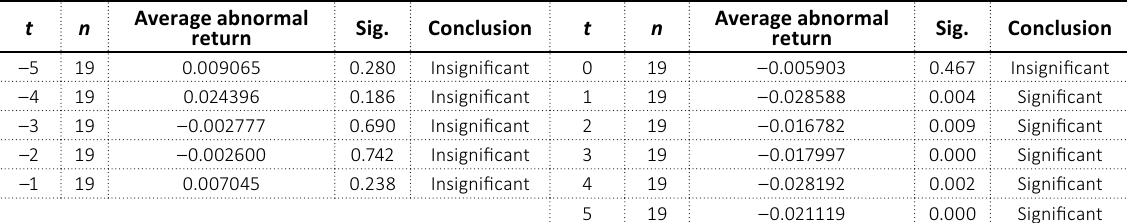
Source: Result of the